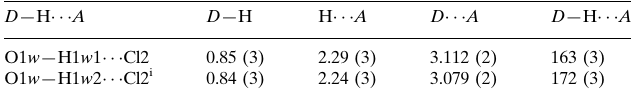
Hydrogen-bond geometry (A˚ , (cid:2)